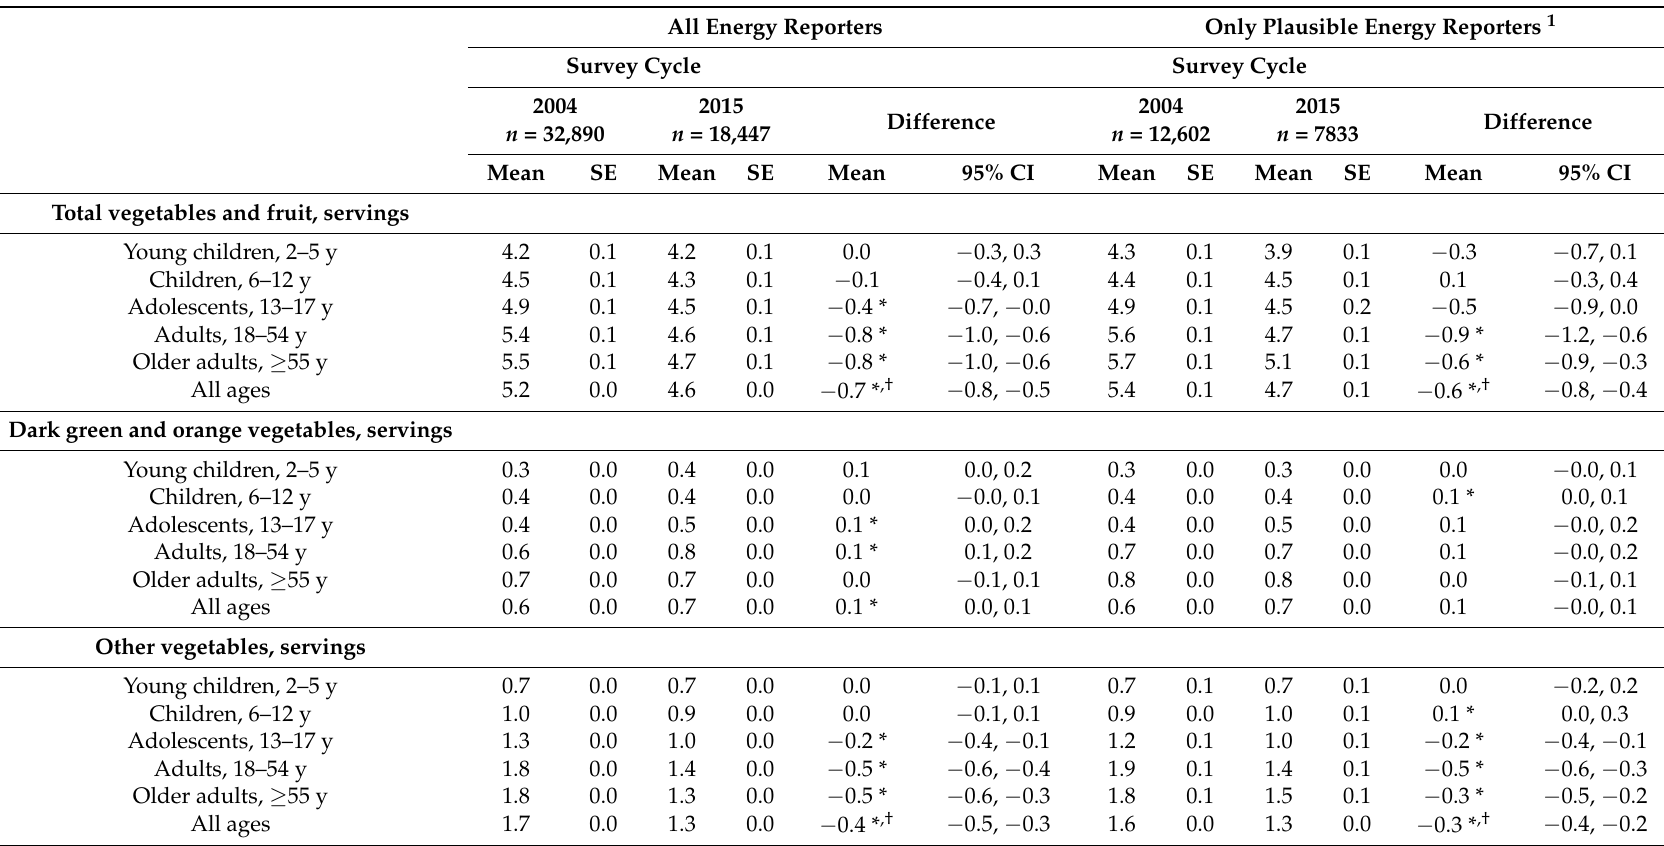
Table 5. Difference in covariate-adjusted mean daily amounts of foods and beverages reported between 2004 and 2015 among Canadians ≥ 2 y (all energy reporters and only plausible energy